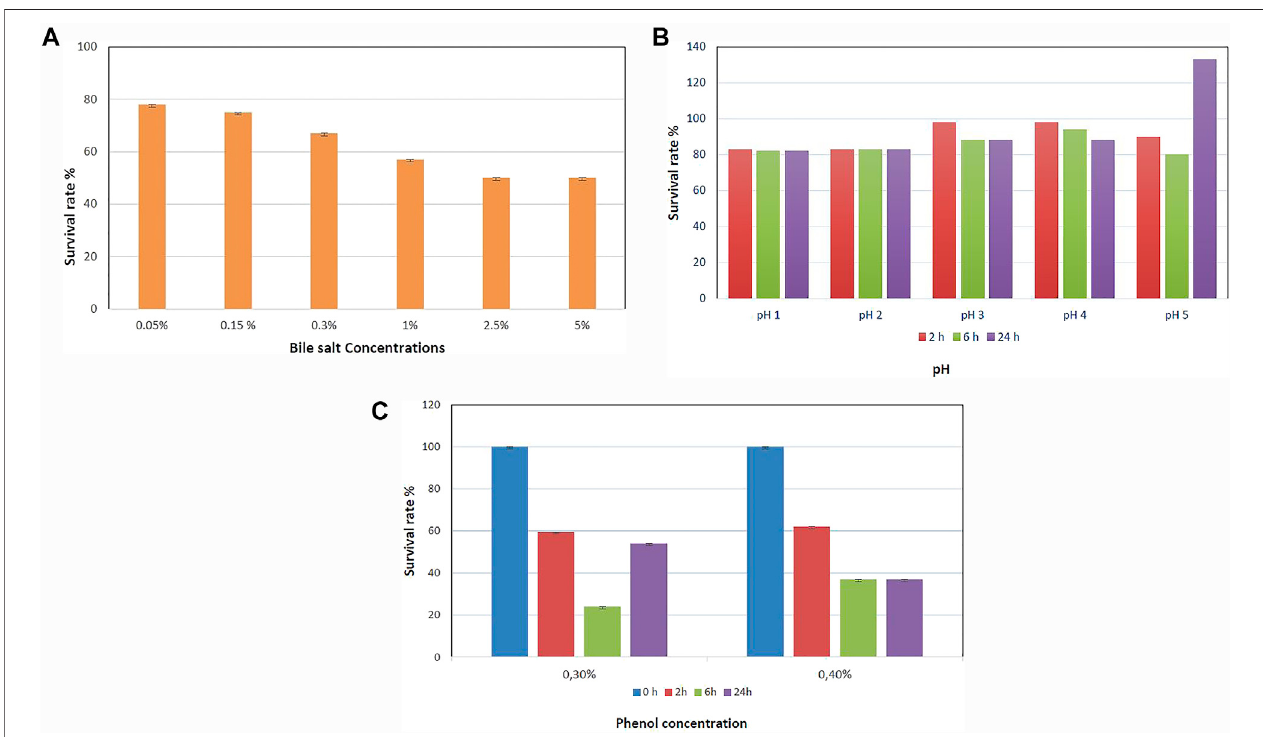
FIGURE 3 | (A) Survival rate of Bacillus paranthracis strain MHSD3 at different concentrations of bile salt, (B) different pH, and (C) different phenol concentrations.